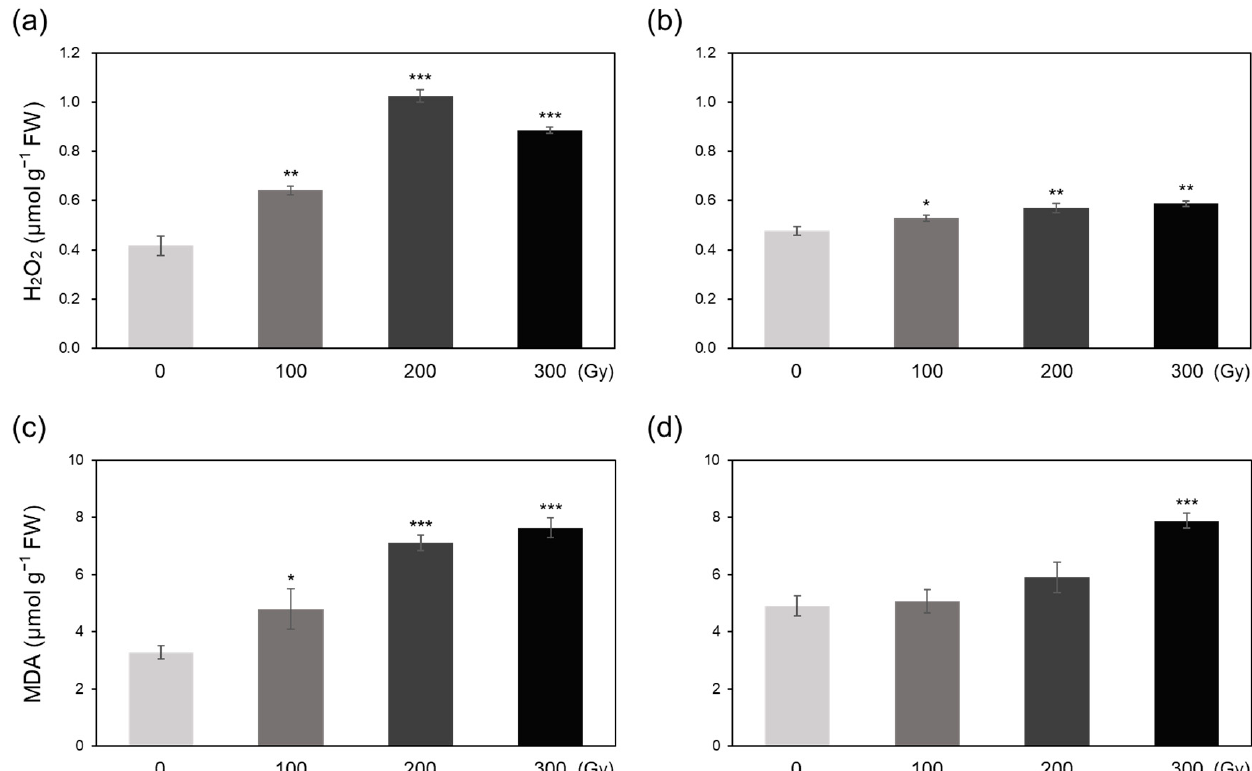
Asterisks indicate significant differences between control (0 Gy) and other treatments (* p < 0.05, ** p < 0.01, *** p < 0.001).